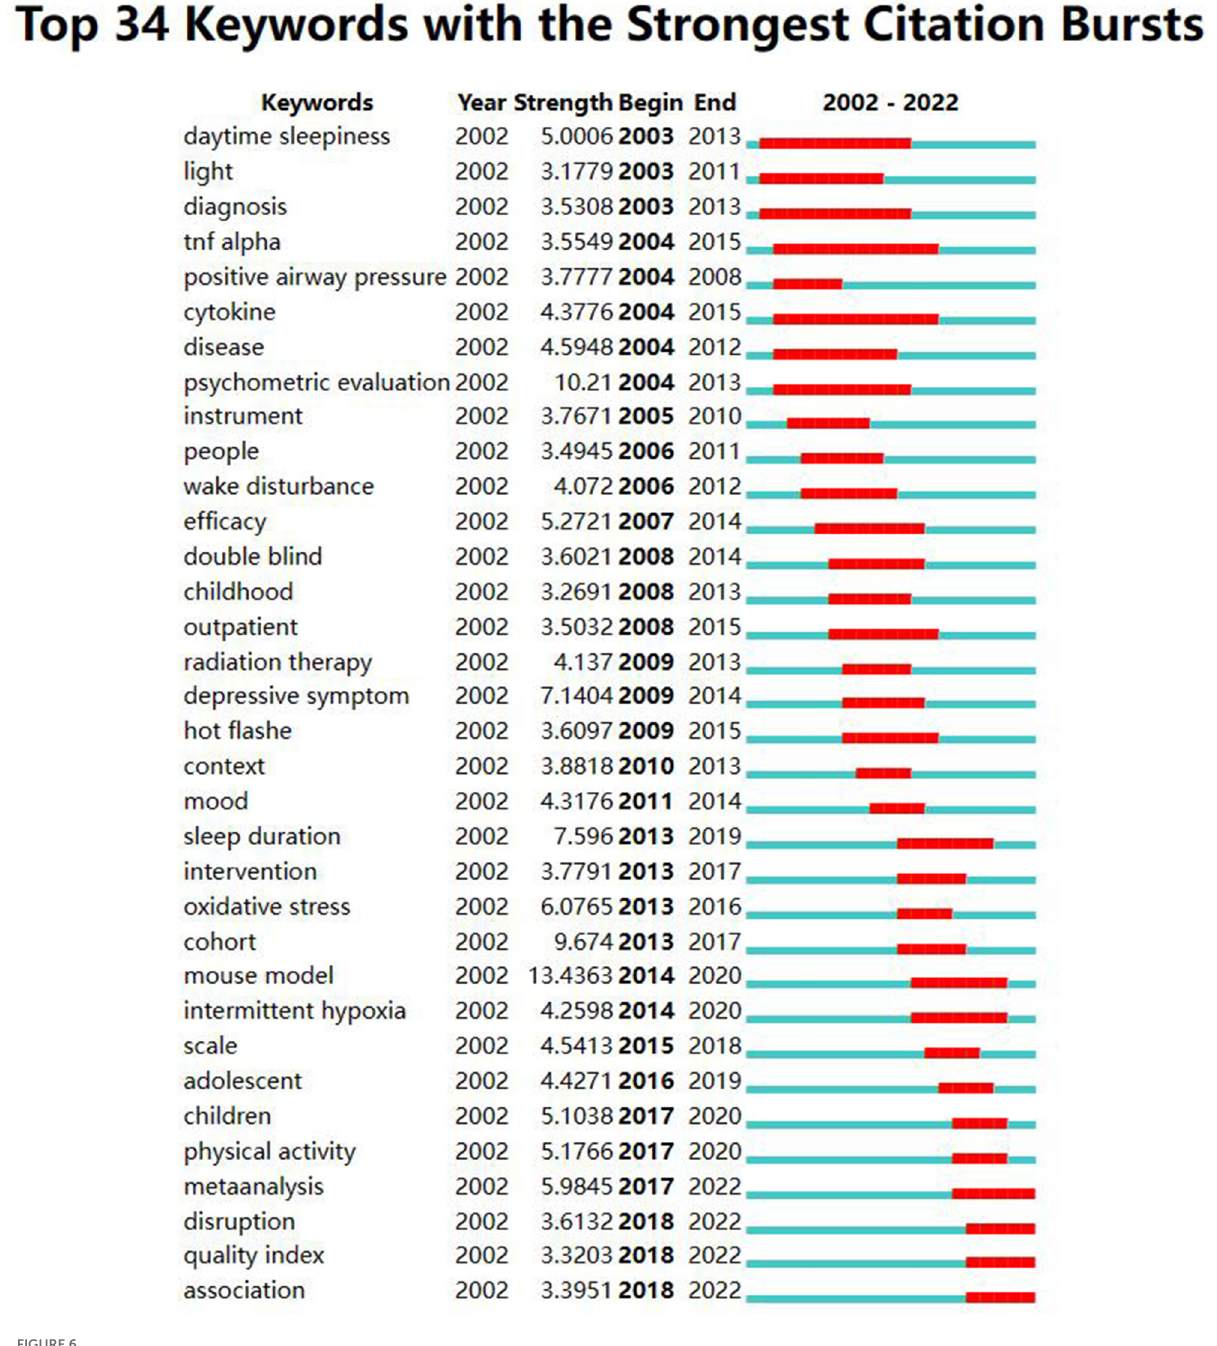
FIGURE6 Top 34 keywords with the strongest citation bursts on cancer and sleep research from 2002 to